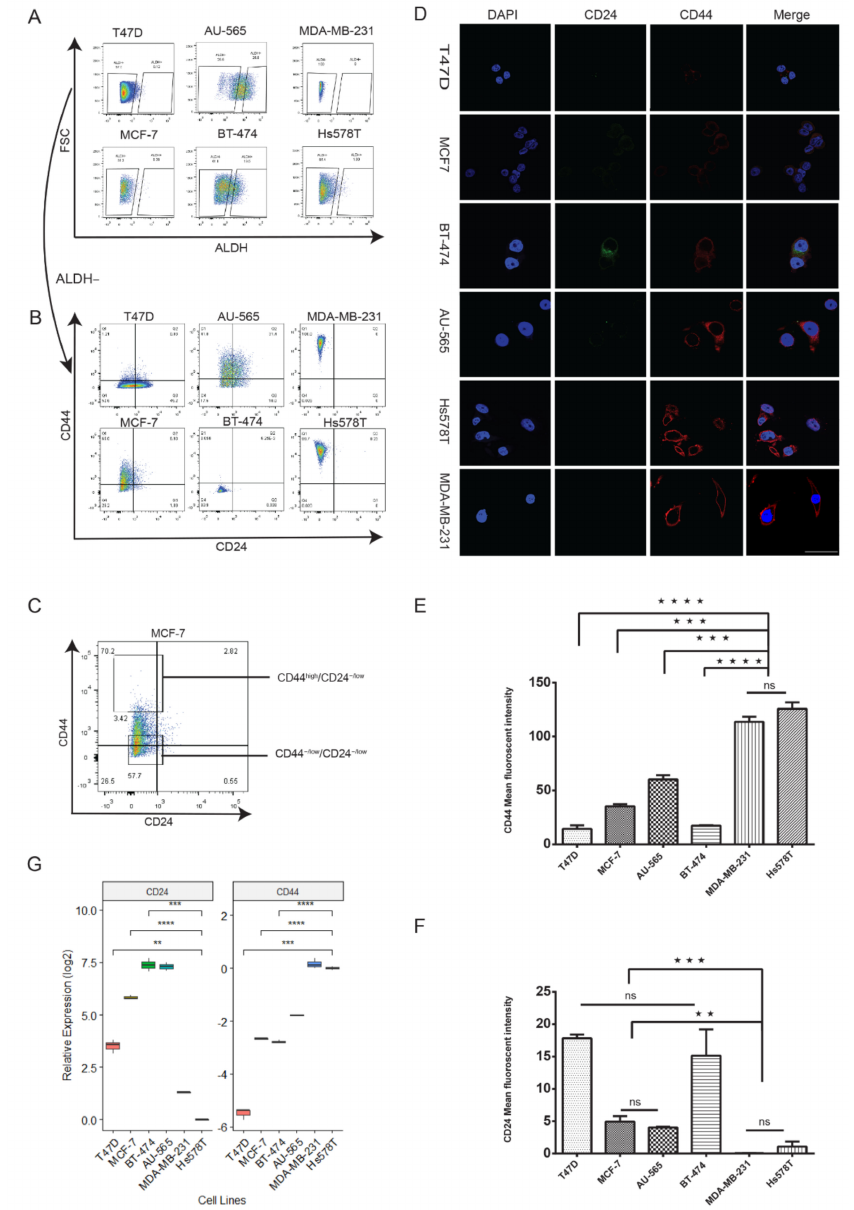
Figure 1. CD44, CD24 and ALDH expression in breast cancer cell lines is subtype dependent ( A , B ) Flow cytometry analysis of ALDH, CD44 and CD24 expression in di ff erent molecular subtypes of breast cancer. Cells were treated with ALDEFLUOR reagent and double stained with anti-CD44-APC (allophycocyanin) and anti-CD24-PerCP-eFluor 710. The accuracy of the double immunostaining was confirmed by comparison with single immunostaining. FSC—forward scatter. ALDH br cells were the highest in HER2-OE cell lines, CD44 − / low / CD24 − / low in luminal and CD44 high / CD24 − / low in triple-negative cell lines (Supplementary Figure S1). ( C ) Representative gating for the selection of CD44 high / CD24 − / low and CD44 − / low / CD24 − / low cells. ( D ) Representative immunofluorescence images showing the expression of CD24 (green), CD44 (red) and DAPI (blue) in breast cancer cell lines. Cells were stained with primary anti-CD24 and anti-CD44 antibodies. Scale bar = 100 µ m. ( E , F ) Comparison of average fluorescence intensities of CD44 and CD24. ( G ) The relative mRNA expression of CD24 and CD44 by qRT-PCR shows that luminal cell lines have a low expression of both CD44 and CD24. All mRNA expression compared to Hs578T. Data represent the mean ± SD of three independent experiments; ** p < 0.01, *** p < 0.001, and **** p <